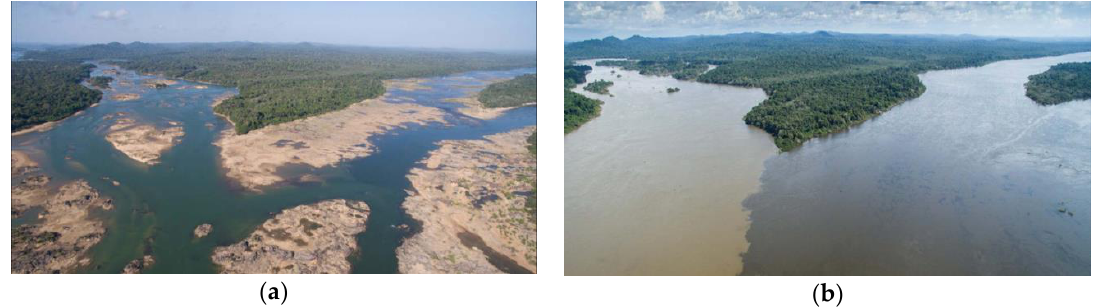
Figure 2. Example of the seasonal difference in exposed substrate between the dry season ( a ) and wet season. ( b ) from the Iriri and Xingu Rivers’ confluence.